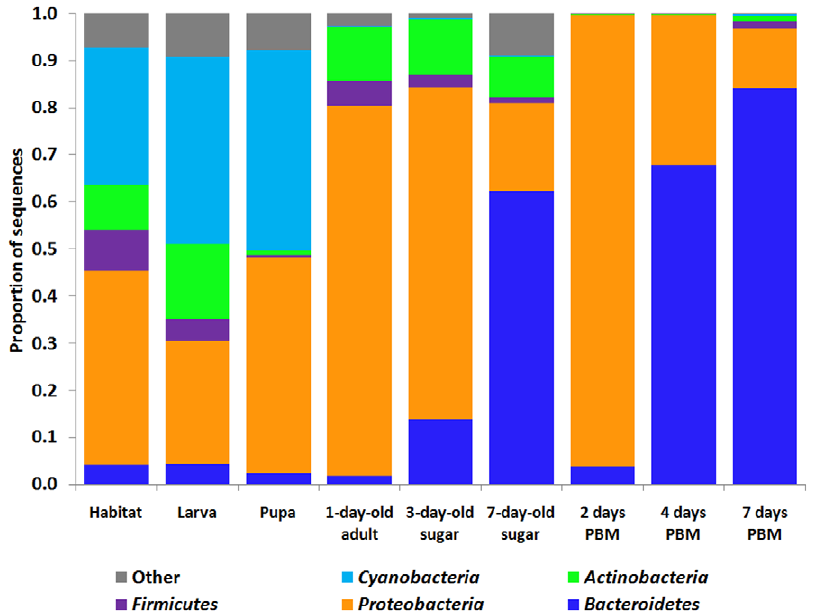
Figure 2. Gut bacterial composition at phylum level in different life stages of An.gambiae in Kenya. Phyla Cyanobacteria , Proteobacteria , Bacteroidetes , Actinobacteria and Firmicutes are presented. Other phyla were pooled as ‘‘Other’’. PBM, post blood meal. Refer Figure S1 for the details